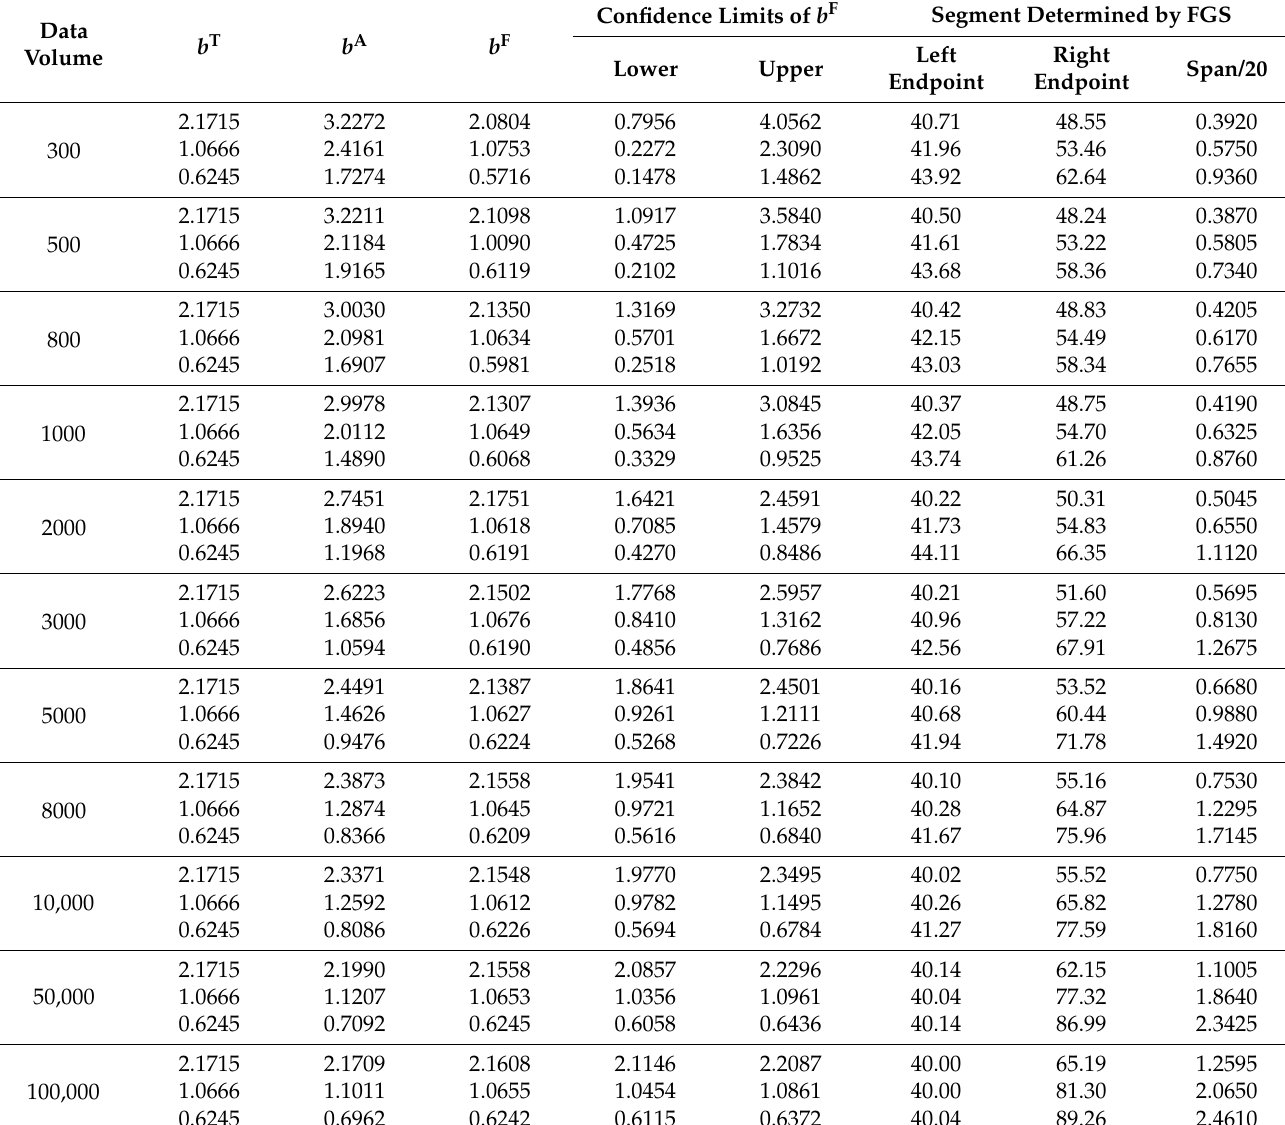
Table 1. b values and corresponding confidence limits estimated by